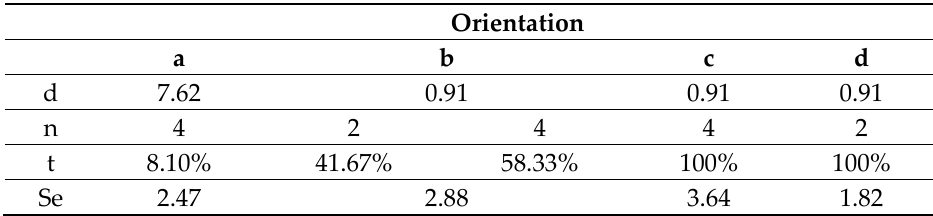
Table 1. Calculation of Se for Each